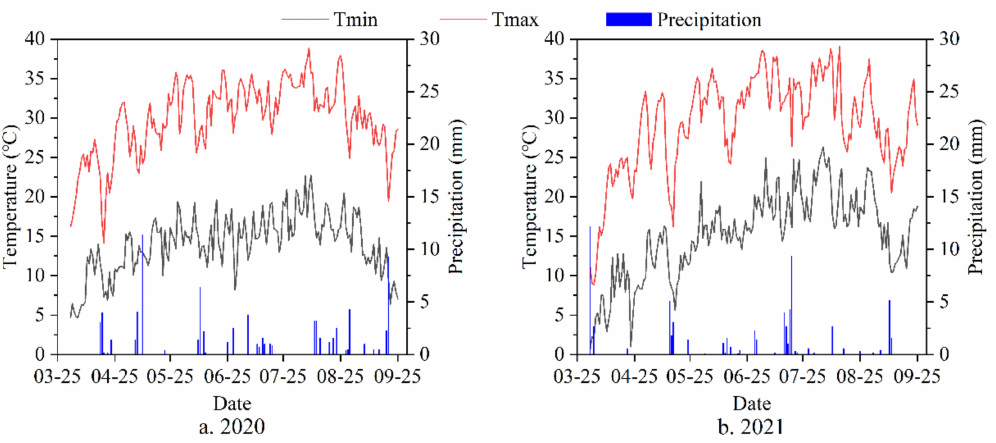
Figure 1. Distribution of precipitation and temperature during cotton growth period of experiment station in ( a ) 2020 and ( b )